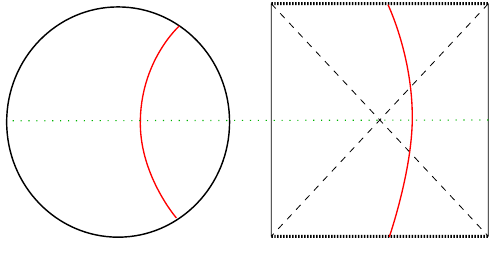
Figure 3 . Illustration of a healthy brane trajectory in Euclidean (left) and Lorentzian (right).